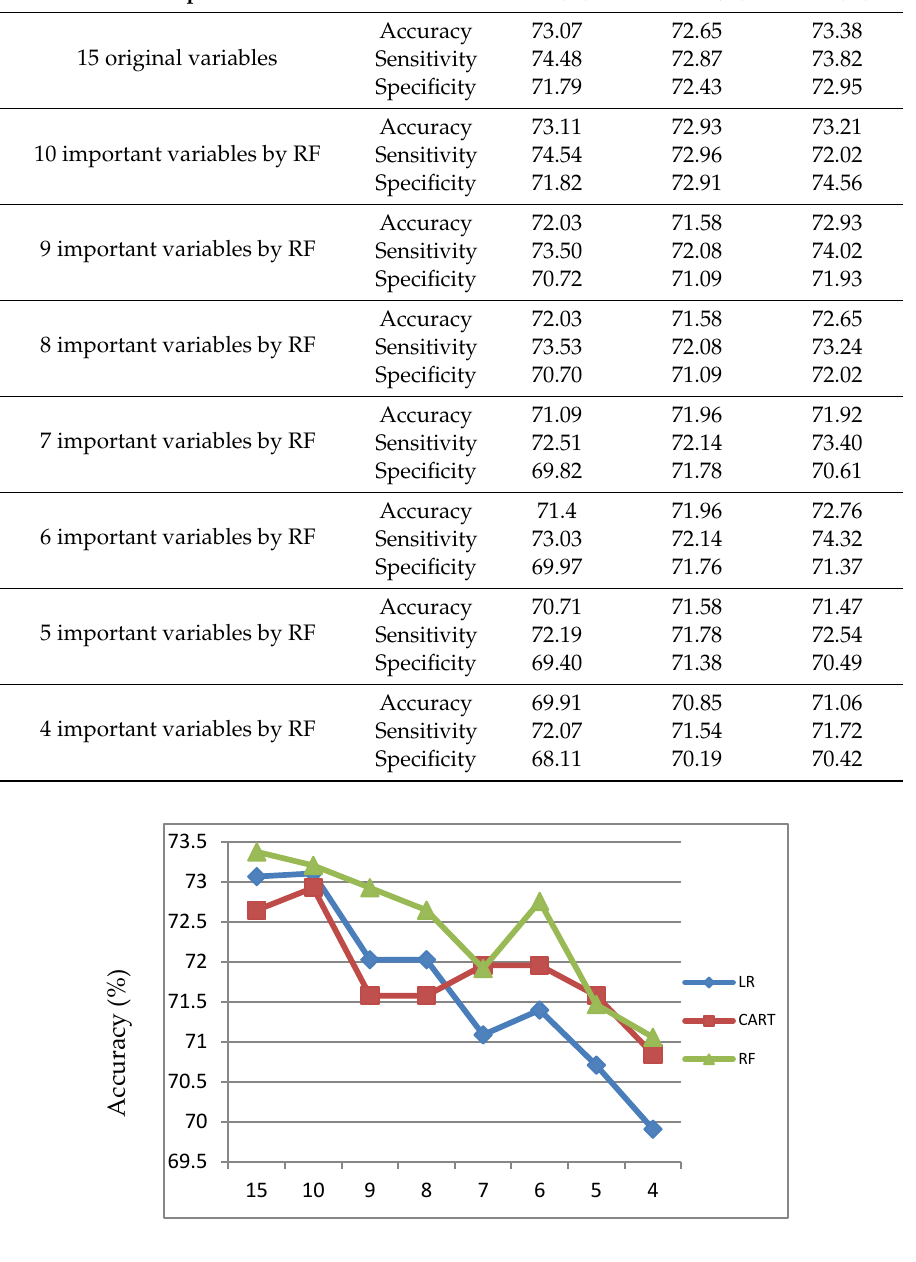
Figure 7. Accuracy of LR, CART and RF with input of important variables identified by RF.